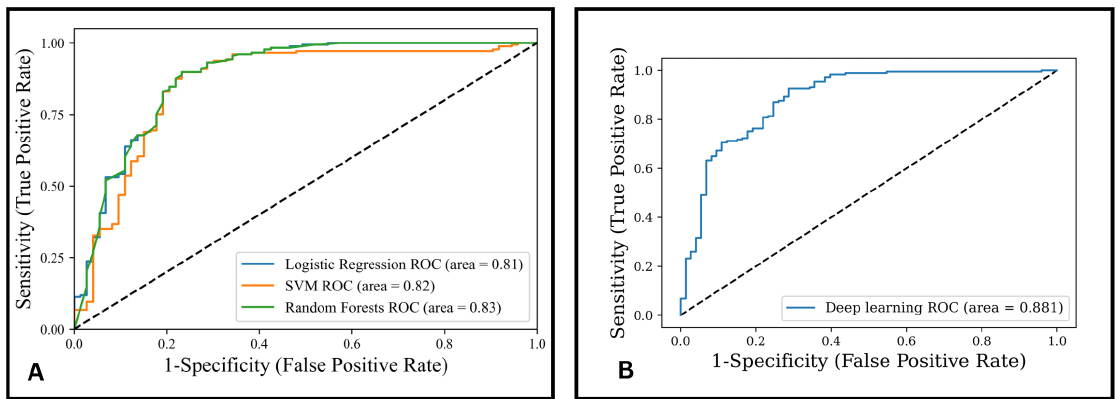
Figure 5. Confusion matrix from the best predictive model: ( A ) 2–Class prediction, ( B ) 3–Class pre- diction SVM, and ( C ) Random Forest 5–Class prediction.